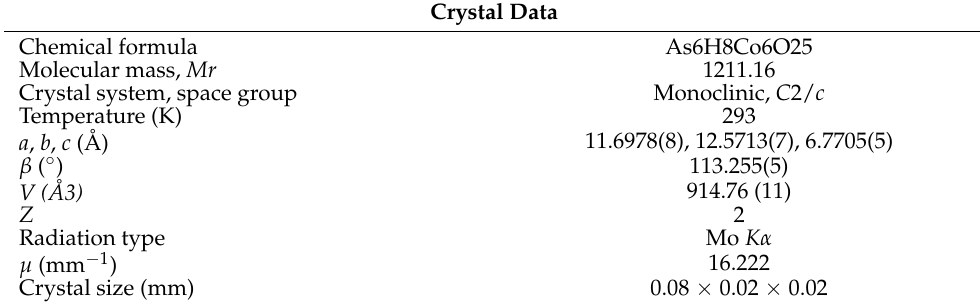
Table 1. Experimental